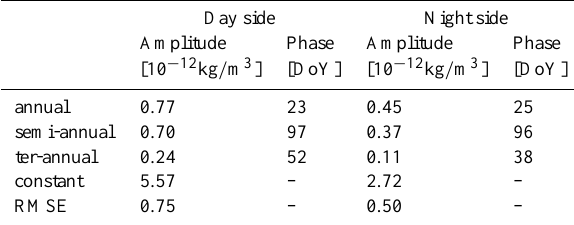
Fig. 5. Ratio between the day and night side densities versus solar flux level. Only days with A p < 15 have been considered. There is practically not dependence on solar flux observed.